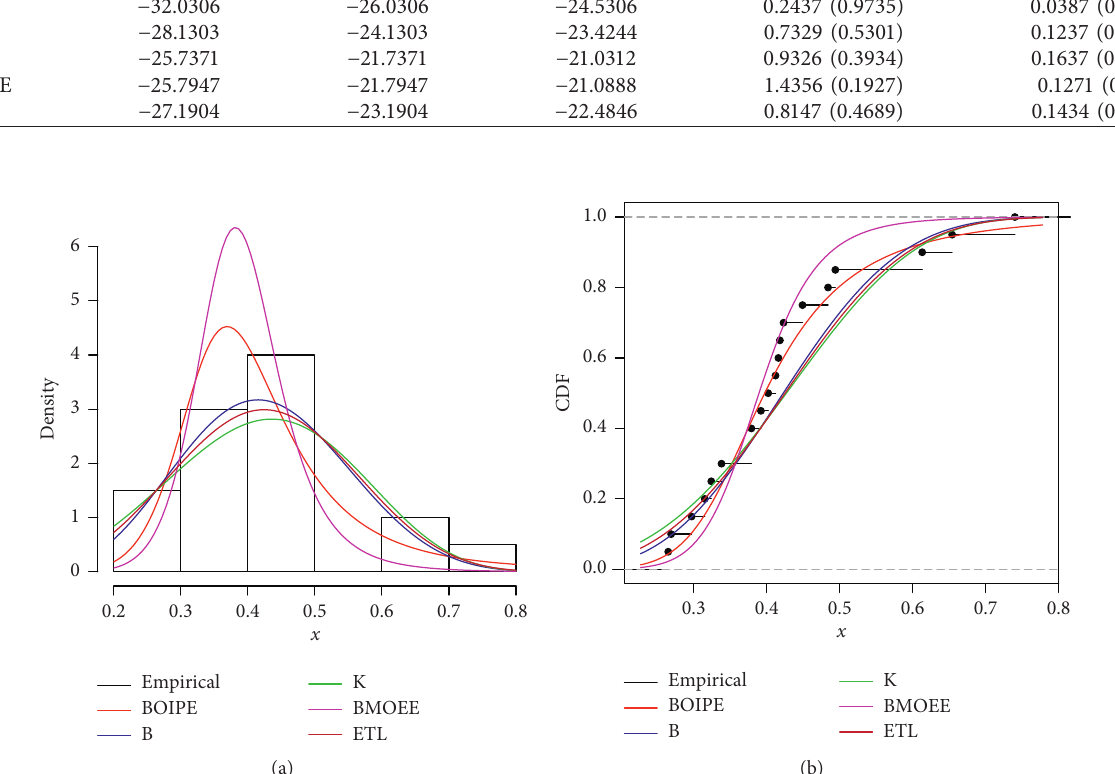
Figure 6: Plots of PDF (a) and CDF (b) of fitted distributions for data II.